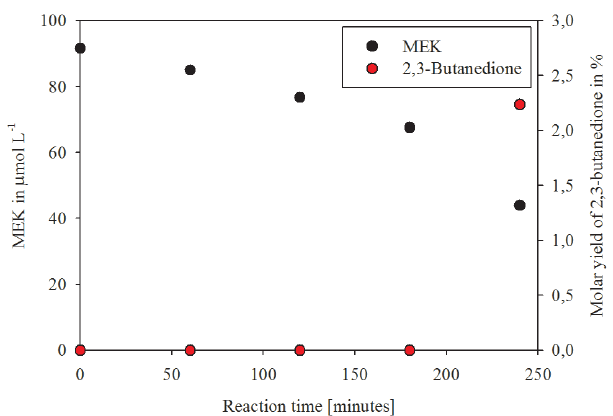
Figure 3. Photolysis of MEK and time-resolved formation of 2,3- butanedione.